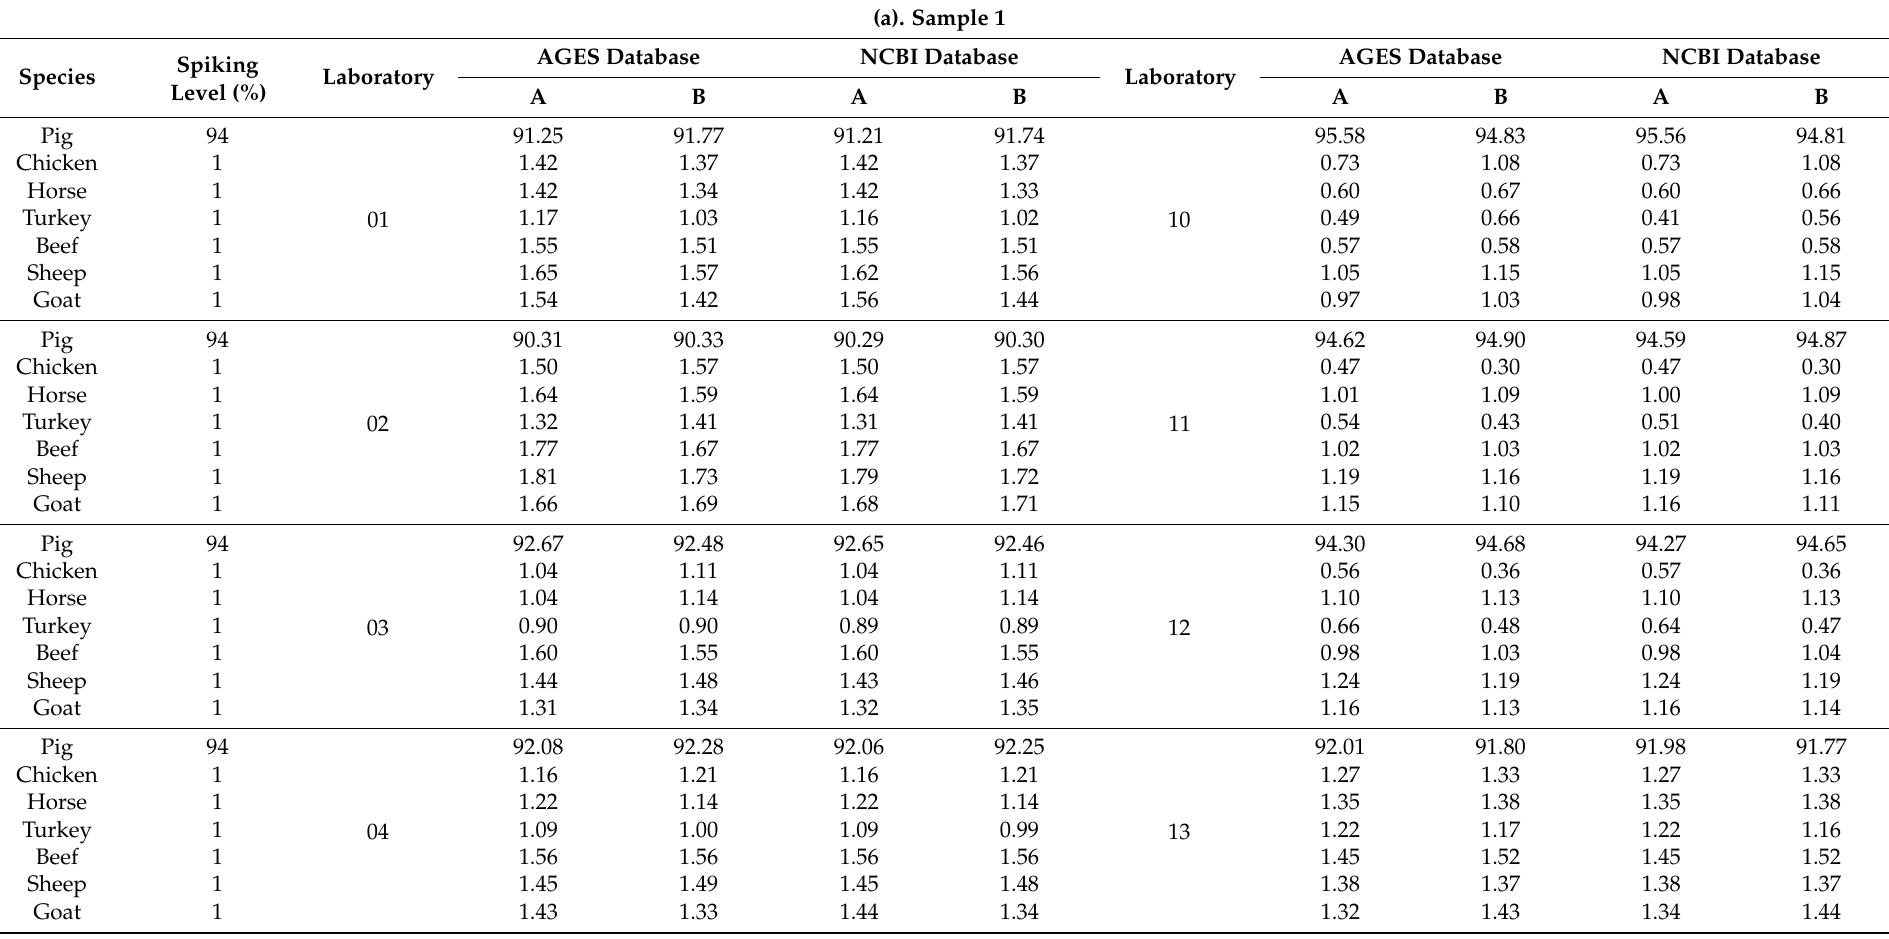
Table 2. Proportion of animal species determined for samples 1 ( a ), 2 ( b ), and 7 ( c ). A and B refer to subsamples A and B, respectively. (a). Sample